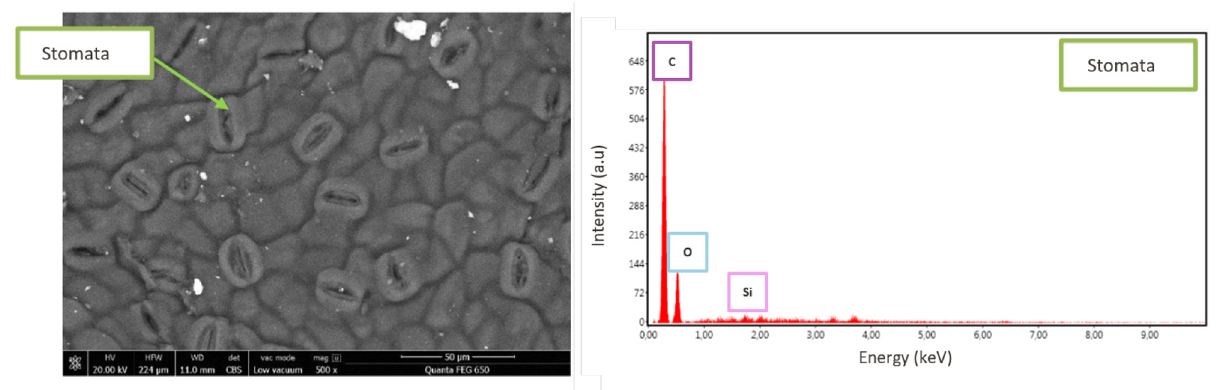
Fig. 24. SEM-EDS (BSE detector, 20 kV) image of stomata composing a leaf particle crushed by a train taken during a field survey and after tests performed under laboratory conditions.